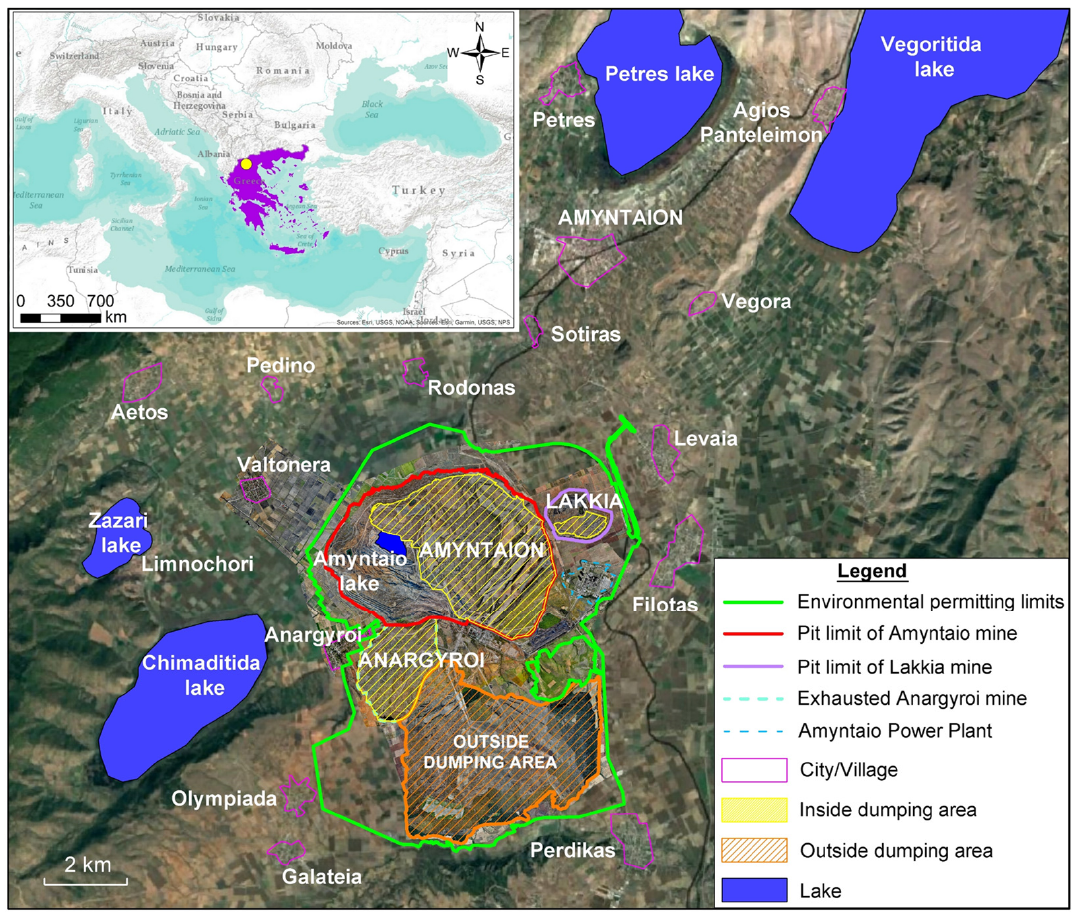
Figure 2. Plan of the Amyntaion area mines (Anargyroi, Amyntaion, Lakkia). The case study (Amyntaion mine) is marked in red. The green boundary shows the limits of the exploitation license.